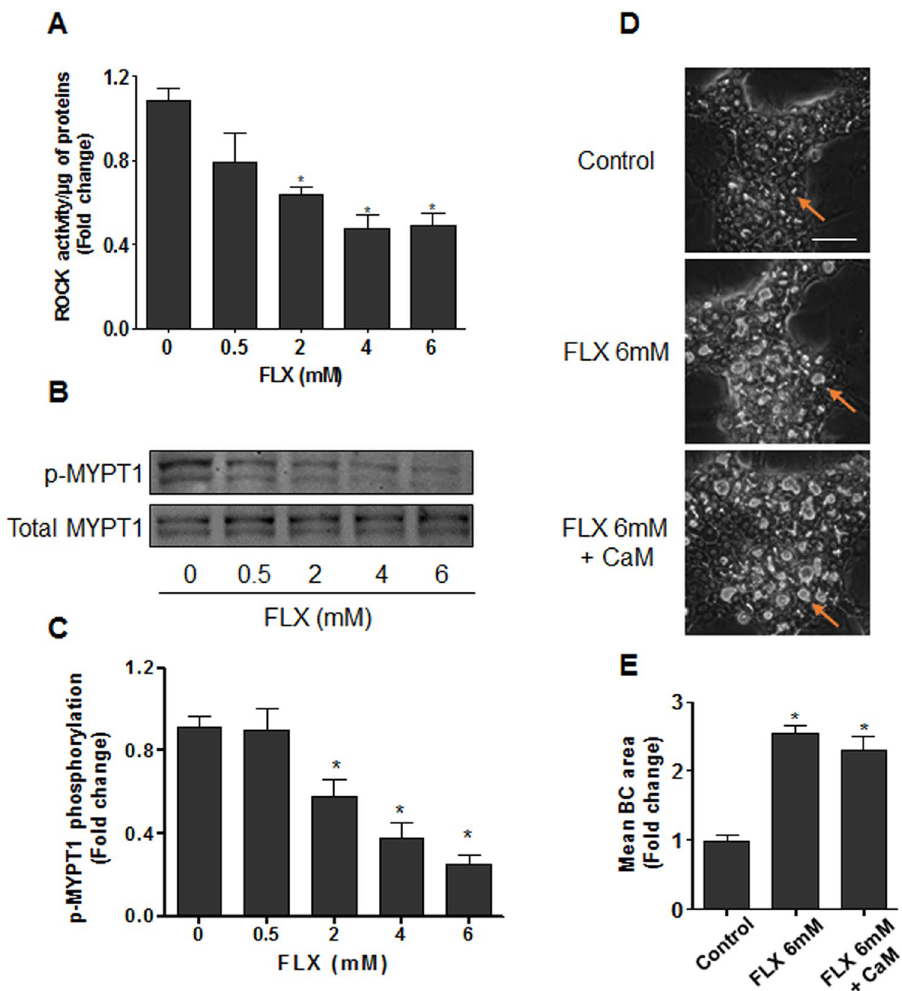
Figure 3. Alteration of ROCK activity and MYPT1 phosphorylation by FLX. ( A ) HepaRG cells were treated with FLX (0–6 mM) for 4 h, then ROCK activity was assessed using a ROCK activity assay Kit